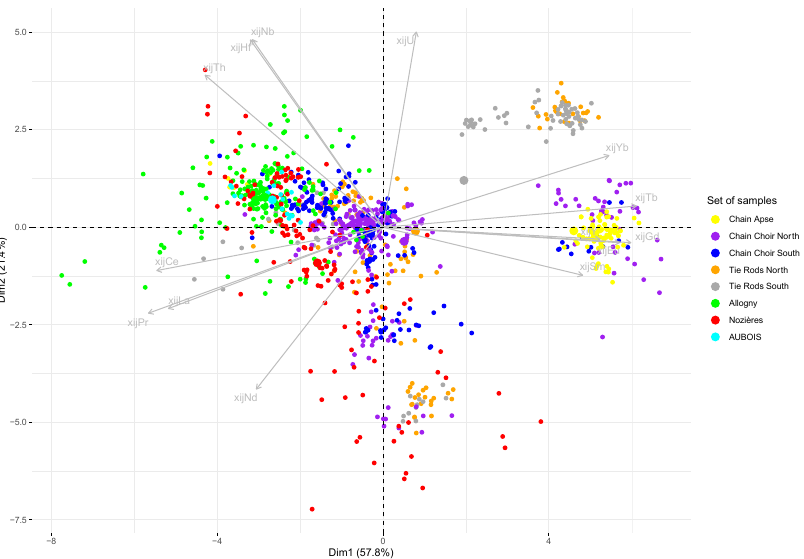
Figure 7. PCA on Xij, three production areas and all objects from the different parts of the cathedral.